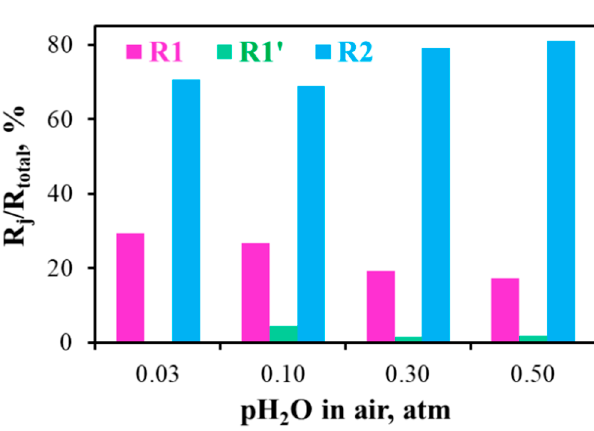
Figure A4. Contribution of partial resistances in the total resistance of the electrodes (R p ). These data were obtained from the DRT results (Figure A3).